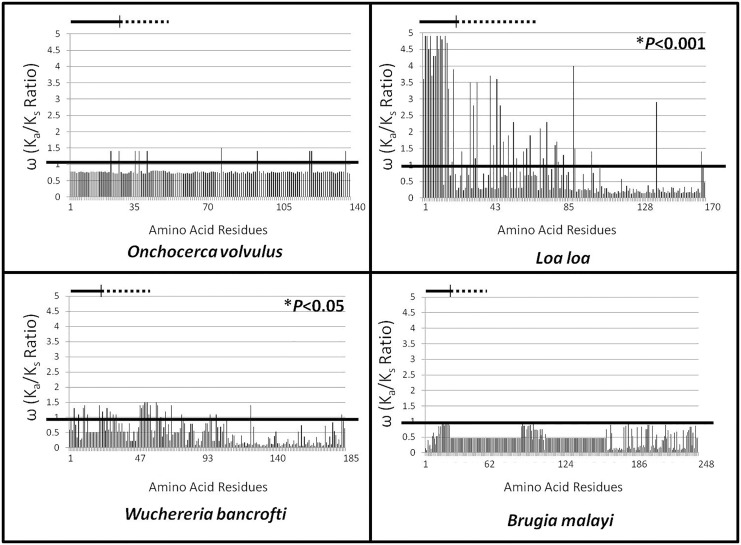
Evolutionary Selection Analysis.Calculated ω values are presented for each amino acid residue (X axis, marked by position number) for ALT-2 from the indicated species using the M8 model. The cutoff ω value of 1 is depicted as a black line; values extended above the line represent residues under diversifying selection, and values below the line represent residues under purifying selection. Statistically significant diversifying selection was detected globally in ALT-2 of L. loa (P<0.001) and W. bancrofti (P<0.05). Residues encompassing the signal peptide are beneath the solid lines, and those encompassing the VAD are beneath the dashed lines.